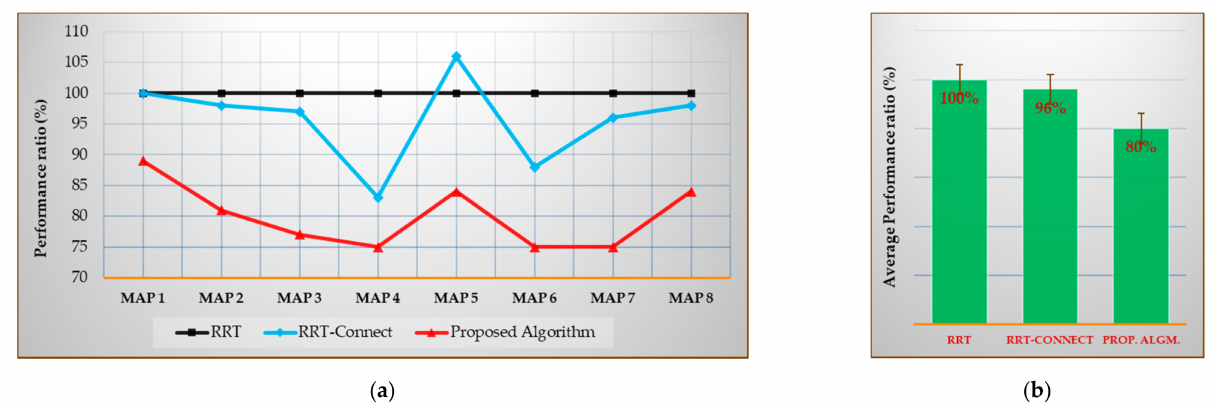
Figure 20. Experimental results in total for the average path length: ( a ) result of each map compared with the RRT algorithm ( x cmp ( i ) ); ( b ) average result compared with the RRT algorithm ( X cmp ).